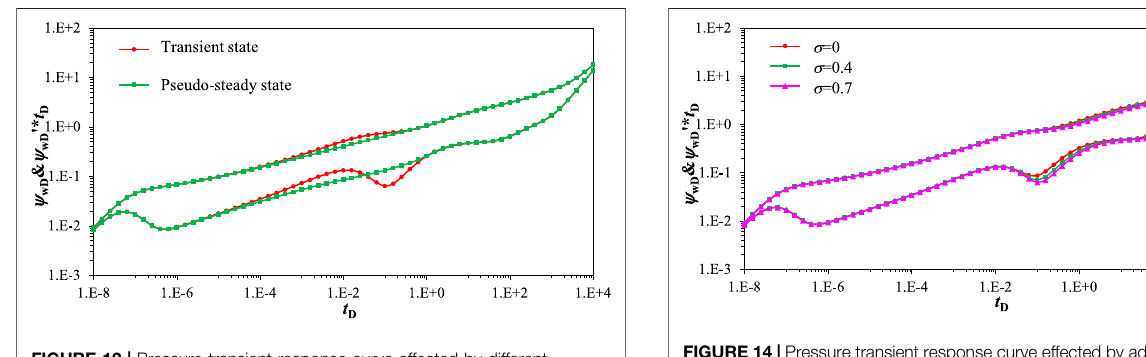
FIGURE 12 | Pressure transient response curve affected by different cross fl ow model. ( C D = 1e-5, S = 0.01, x asymD = 0.3, L F = 150 m, θ F = 90 o , C FD = 10, R e = 3000 m, r o = 2000 m, ω = 0.1, λ = 1, σ = 0.7, β m = 3).